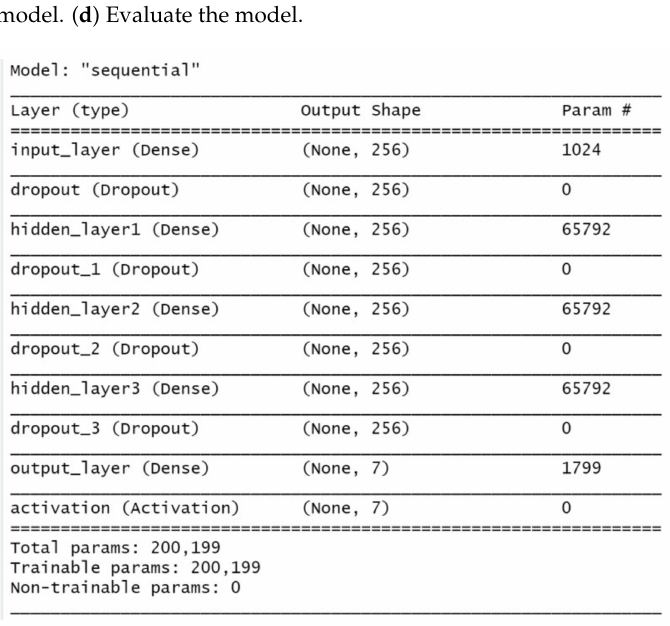
Figure 4. Deep learning